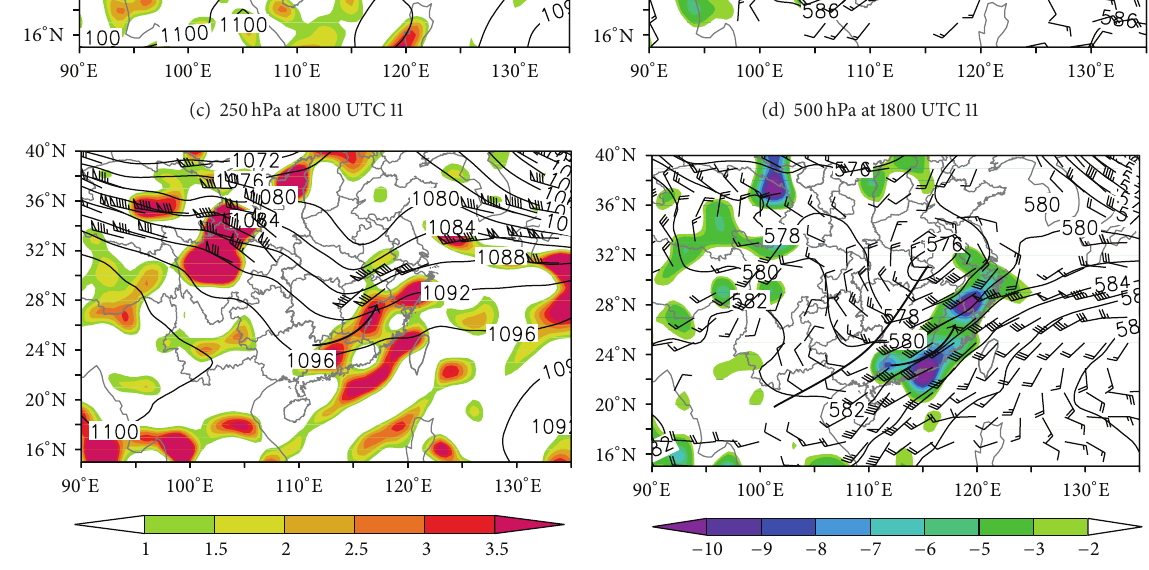
For example, the strong ascending motion was in Yunnan- Guizhou border area (Figure 3(c)) in the first stage and South China area (Figure 3(d)) in the second phase. (3) In the first stage (Figure 3(e)), convergence stream field of the low vortex was in Yunnan-Guizhou border area, but the LLJ was on ocean surface in the east; in the second stage (Figure 3(f)), the convergence stream field was mainly in Guangxi and Guangdong with obvious LLJ in front of the vortex. Discussed above is the time-mean circulation, the distri- bution of atmosphere circulation is drawn at different times